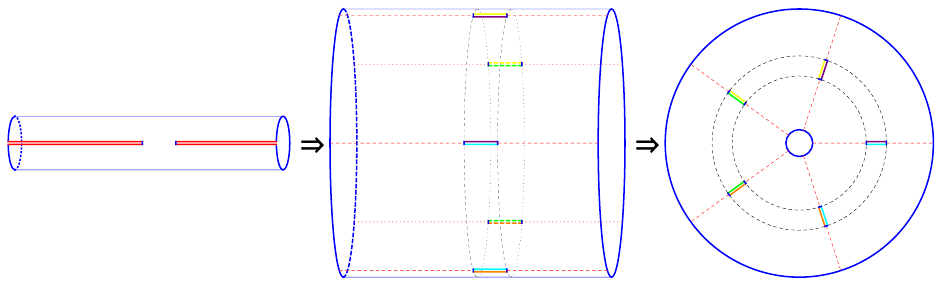
Figure 3 . Illustration on the computation of long interval R(cid:19)enyi entropy. In the left (cid:12)gure we have the original cylinder R with a length L and a temporal period (cid:12) . The long interval [ (cid:0) L= 2 ; v ] [ [ u; L= 2] with u (cid:0) v = ‘ (cid:28) L has length L (cid:0) ‘ . Via the replica trick and deforming the interval we get a cylinder R n with a length L , a temporal period n(cid:12) and n cuts, as shown in the middle